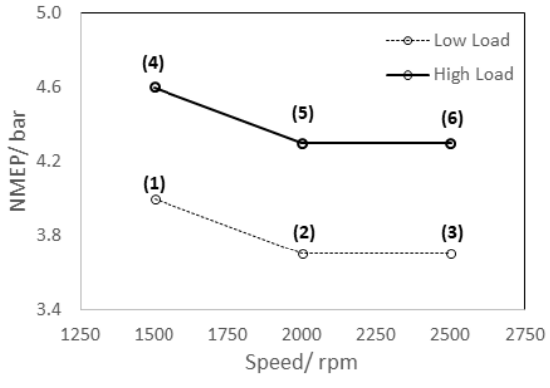
Fig. 1. Selected points on speed/load map from this study